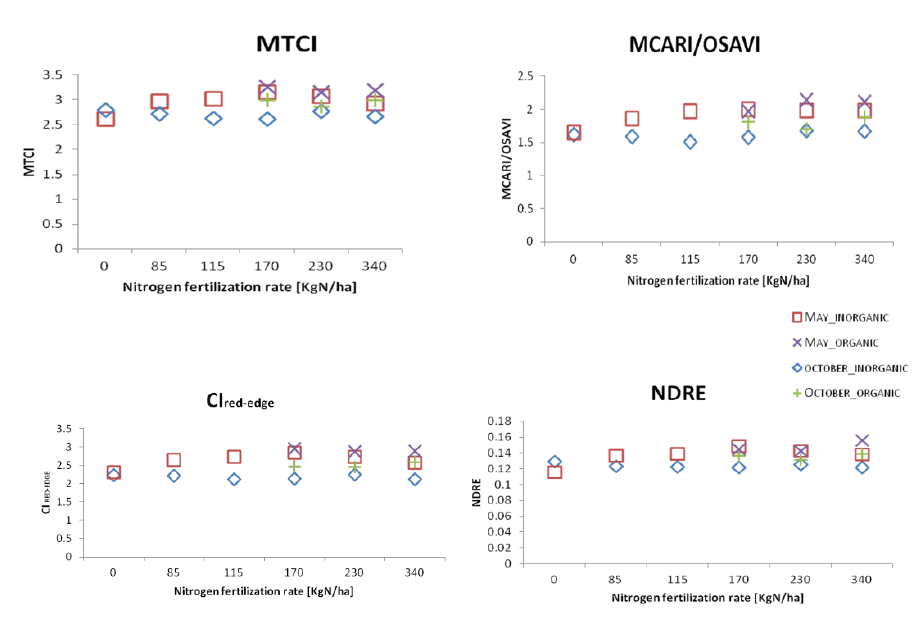
Figure 7. Scatterplot related to the influence of the type and the amount of fertilizer on selected narrow-band vegetation indices.